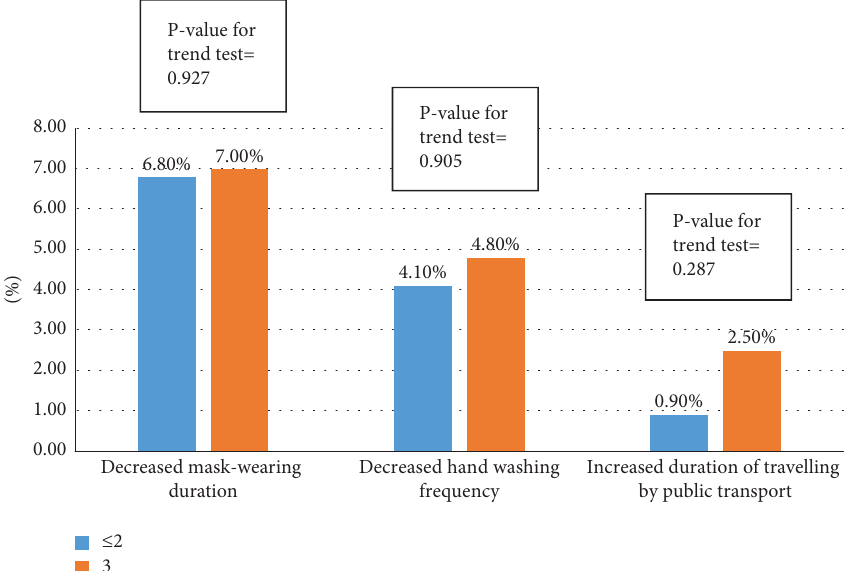
Figure 4: Association between number of vaccine doses received and harmful health